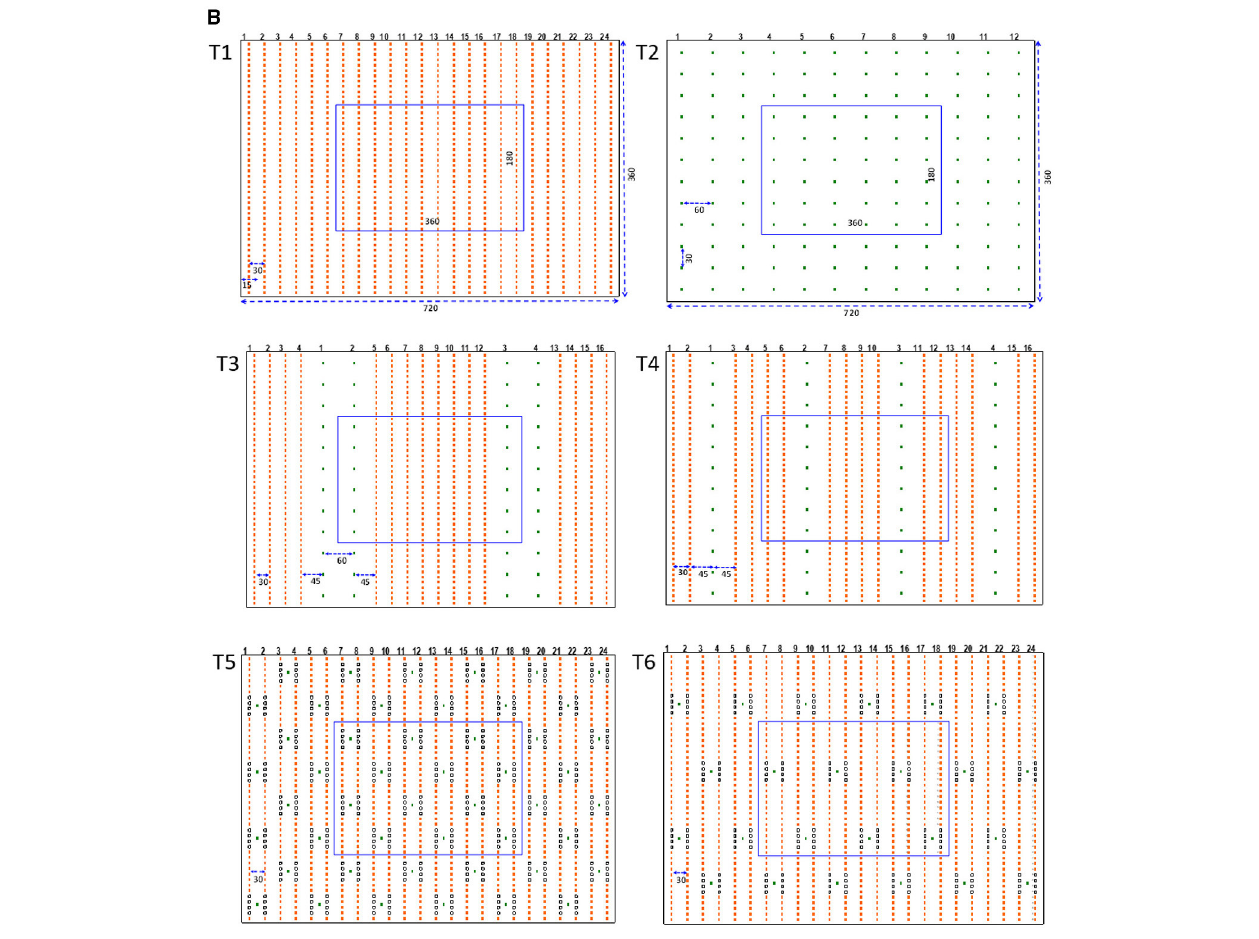
FIGURE 1 | (A) Field site at Kolli Hills, India, with various spatial arrangements of component crops pigeon pea (PP) and finger millet (FM) in intercropping systems. (B) Schematic diagram of the different spatial crop arrangements. Top row: monoculture of FM (T1) and PP (T2). Middle row: 2:8 (PP:FM) row-wise intercropping pattern (T3) and 1:4 (PP:FM) row-wise intercropping pattern (T4). Bottom row: 100% (T5) and 50% (T6) mosaic intercrop design.